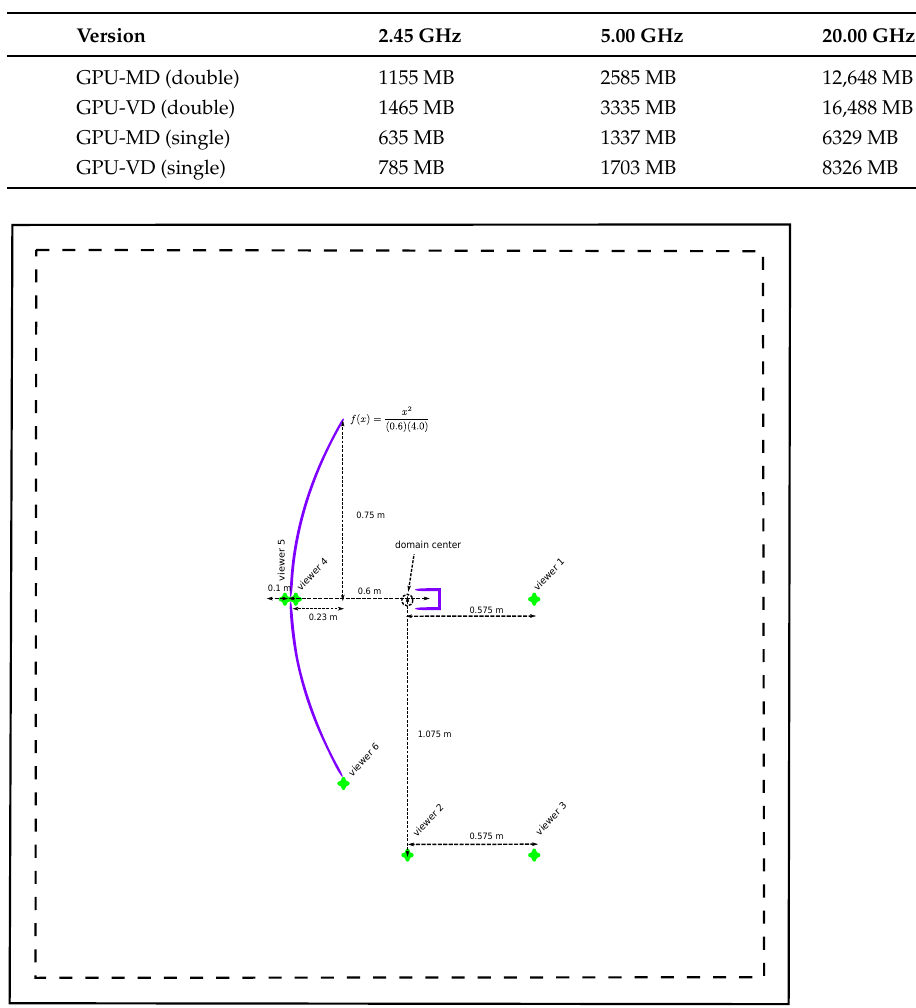
Figure 13. Configuration for the parabolic plate propagation scenario. The green dots indicate the location of the control points. The source is located inside the hood feeder.